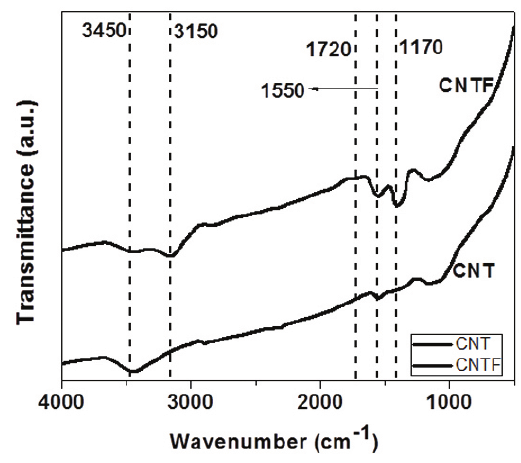
Figure 6. FT-IR spectrum of the MWCNT-F sample, corresponding to the first of the two steps Ag decorating procedure. Pristine MWCNT spectrum is also present, for comparison